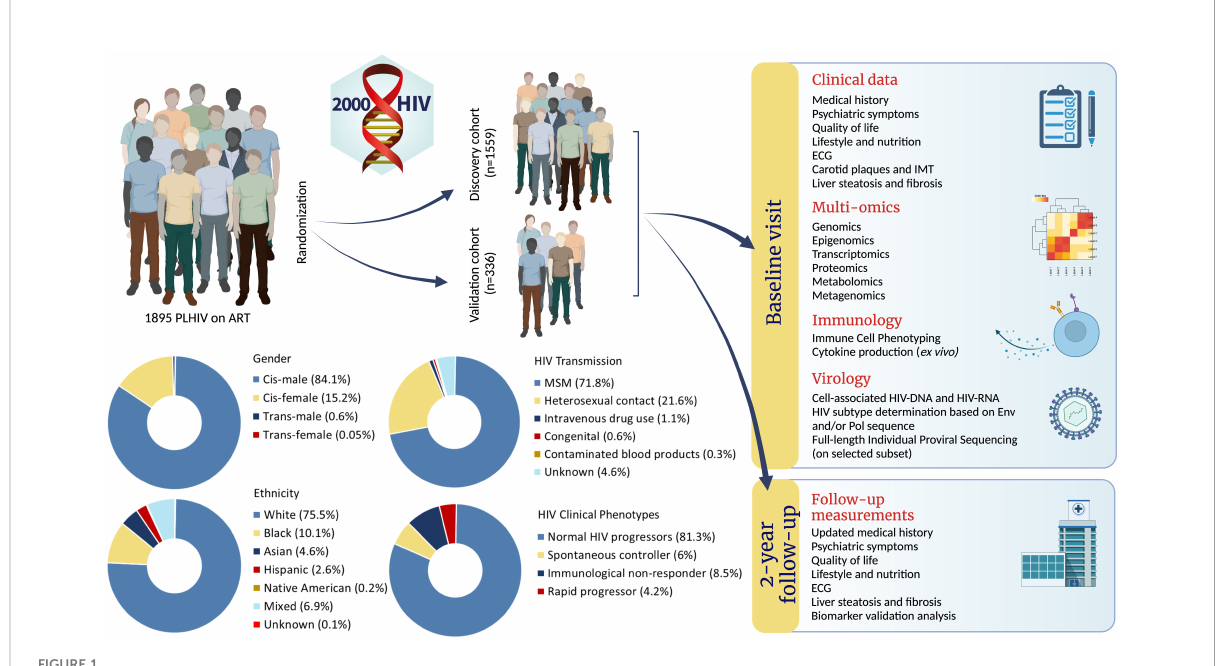
FIGURE 1 Abstract fi gure: Infographic of 2000HIV study. (Image created with